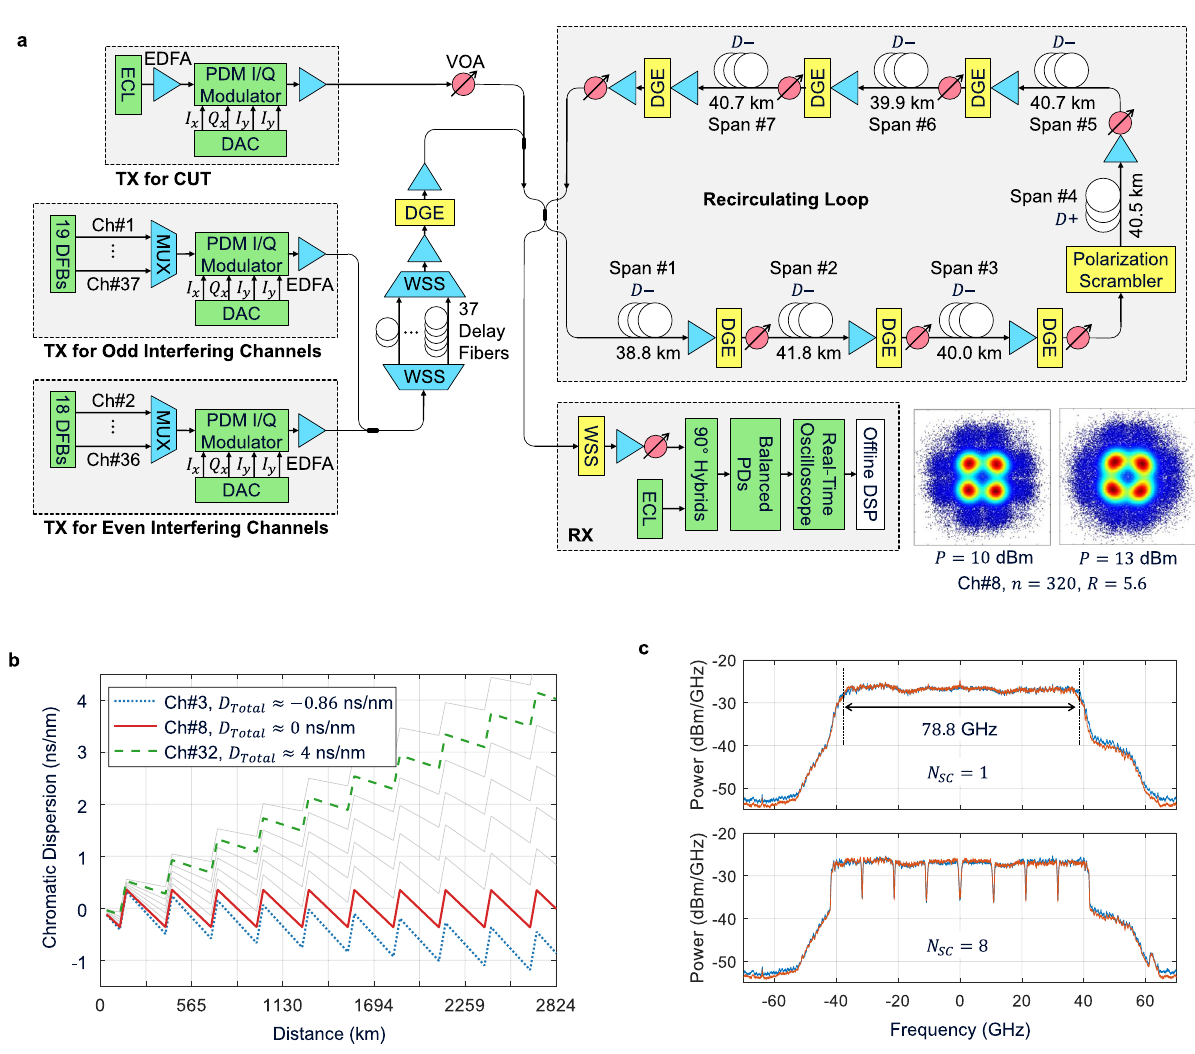
Fig. 4 Experimental system to verify the performance of optimal sphere shaping in full C-band transmission. a Schematic of the experimental setup. Inset: typical recovered constellations at the receiver. b Dispersion map of various WDM channels over the optical fi ber link. c Typical received power spectral densities when a single (upper fi gure) and eight (lower fi gure) digital subcarriers are